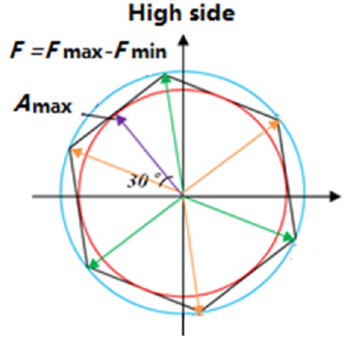
Fig. 3 Vector geometry of the maximum steering force